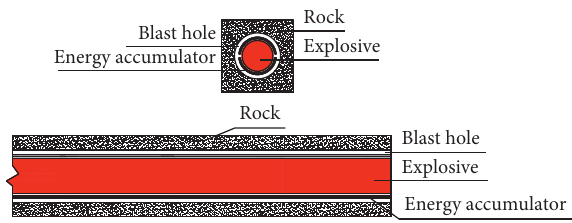
Figure 15: Chart of the explosive